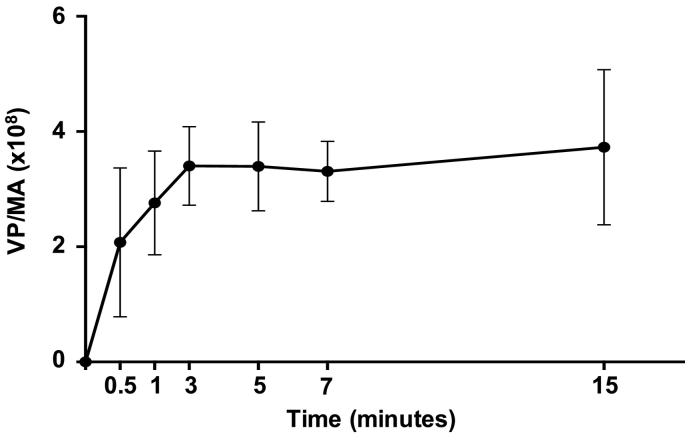
In vivo vaccine release profile from microneedle arrays encapsulating a rAdHu5 encoding HIV-1 CN54 gag. MAs containing a rAdHu5 vector encoding HIV-1 CN54 gag within a water-soluble matrix were applied to murine back skin over a time course of 0.5 to 15 min. After application, the remaining MA base-plates were dissolved in PBS to release residual encapsulated virus and rAdHu5-CN54gag titre quantitated by PicoGreen assay as virus particle number (vp). rAdHu5-CN54gag delivered to the skin per single MA was calculated as the difference in MA vp number before and after application. Data are pooled from two independent experiments, n = 6–10 per each time point.